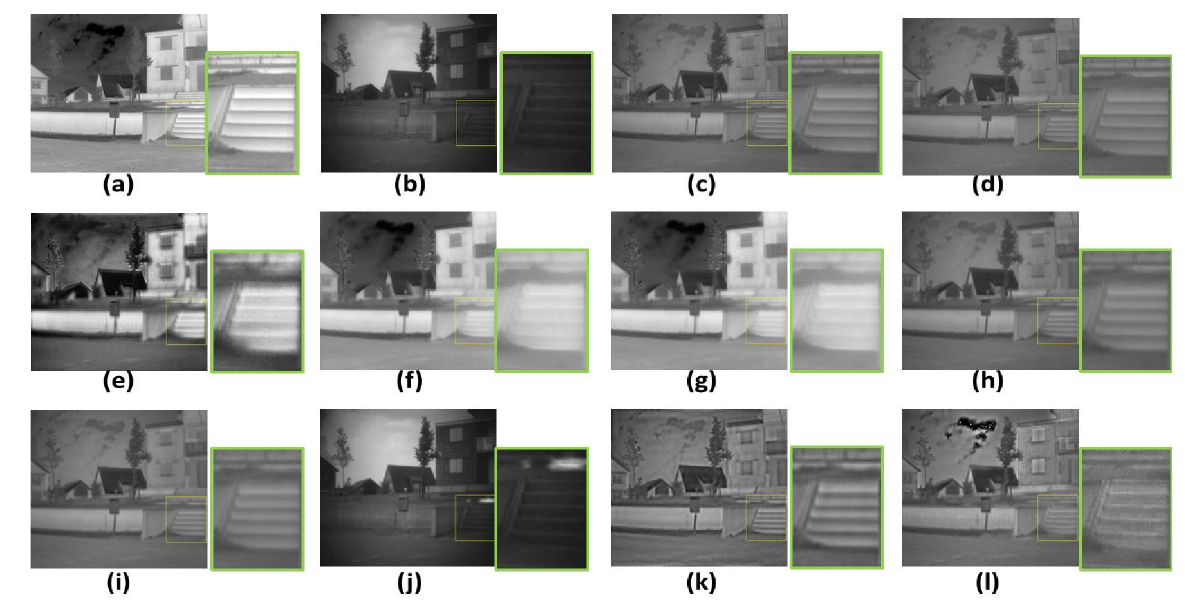
Figure 9. Visual IF results of different methods on marne : ( a ) IR image, ( b ) VIS image, ( c ) Proposed method, ( d ) [17], ( e ) [22], ( f ) [33], ( g ) [20], ( h ) [34], ( i ) [35], ( j ) [36], ( k ) [37], and ( l ) [38].